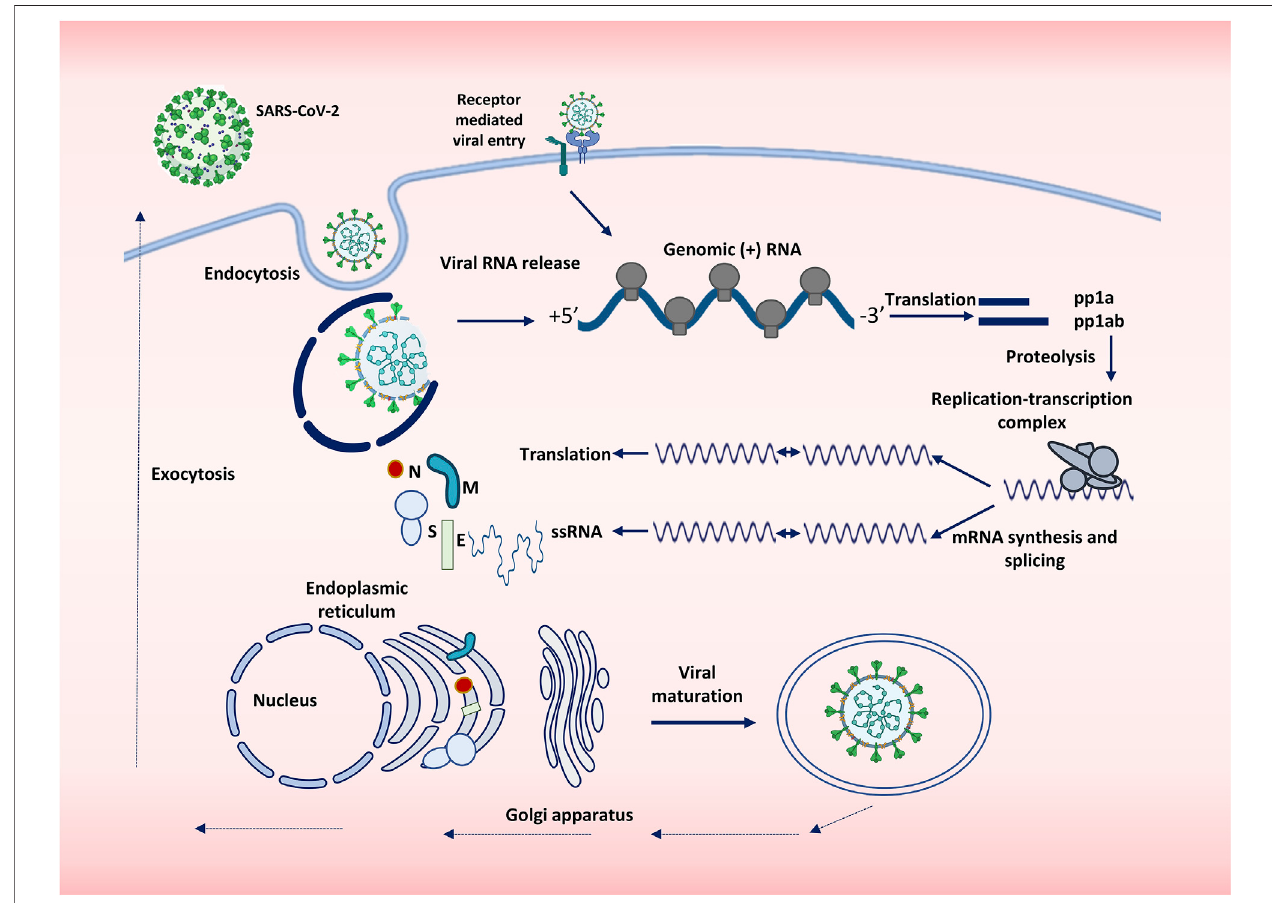
FIGURE 1 | Replication cycle of SARS-CoV-2. SARS-CoV-2 enters the cell either by endocytosis or by receptor mediated membrane fusion. The genome of the virus is released and is subjected to replication and translation. Viral proteins are synthesized, and single stranded RNA is produced, both of which are assembled with the help of Endoplasmic reticulum and Golgi apparatus. The virions thus assembled are then transported outside the body by exocytosis.